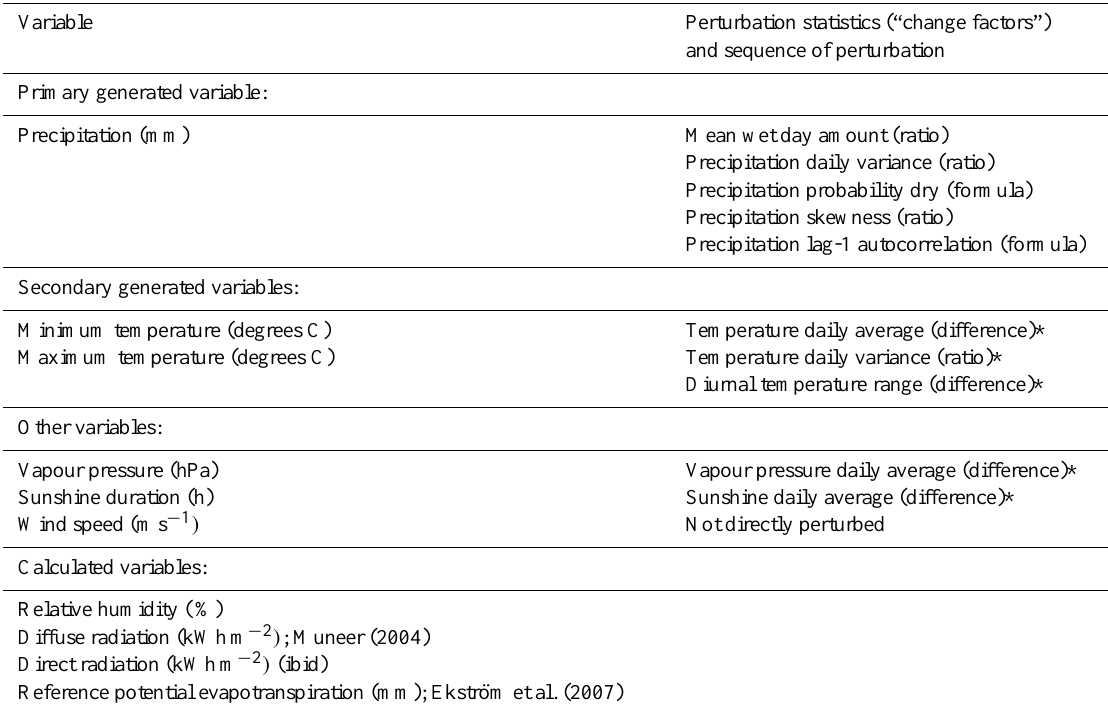
Table 1. Weather variables produced by the Daily